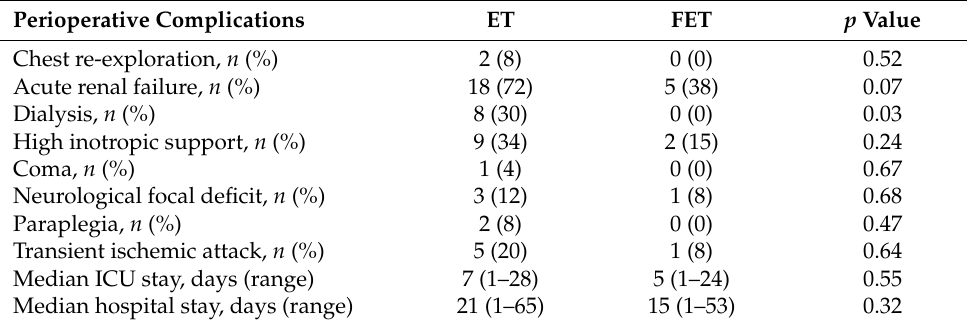
Table 7. Perioperative complications according to the classical and frozen